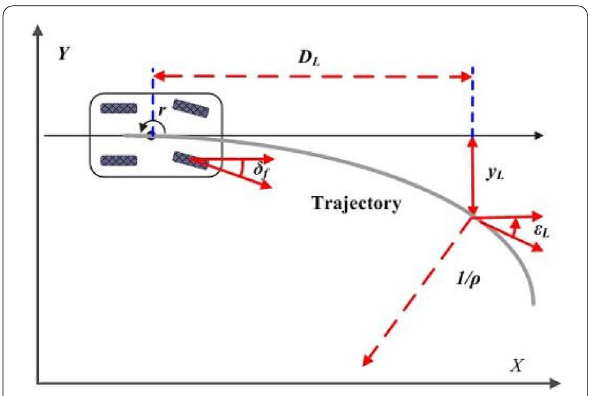
Figure 1 Kinematics model of automated electric vehicle